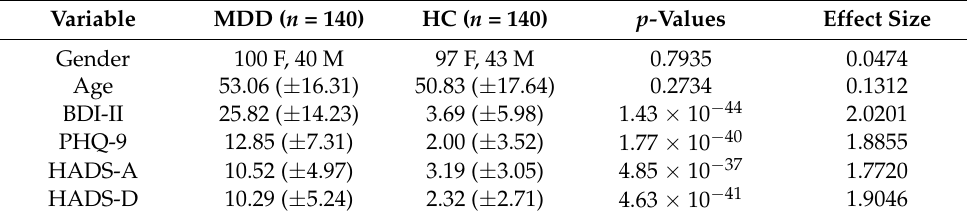
Table 2. Demographic data and scores of questionnaires for participants in the training set.